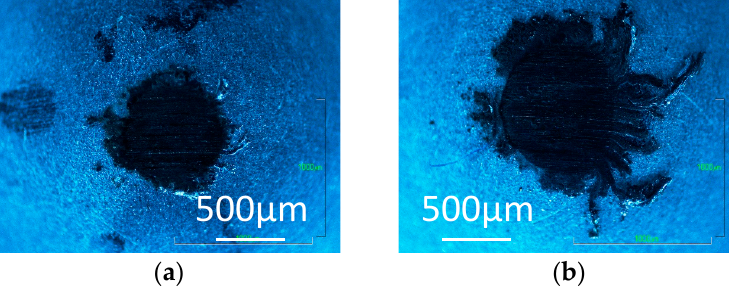
Figure 9. Photographs of aluminum pins slid against ta-C DLC in hydrogen; with ( a ) 0 ppm water; and ( b ) 120 ppm water.